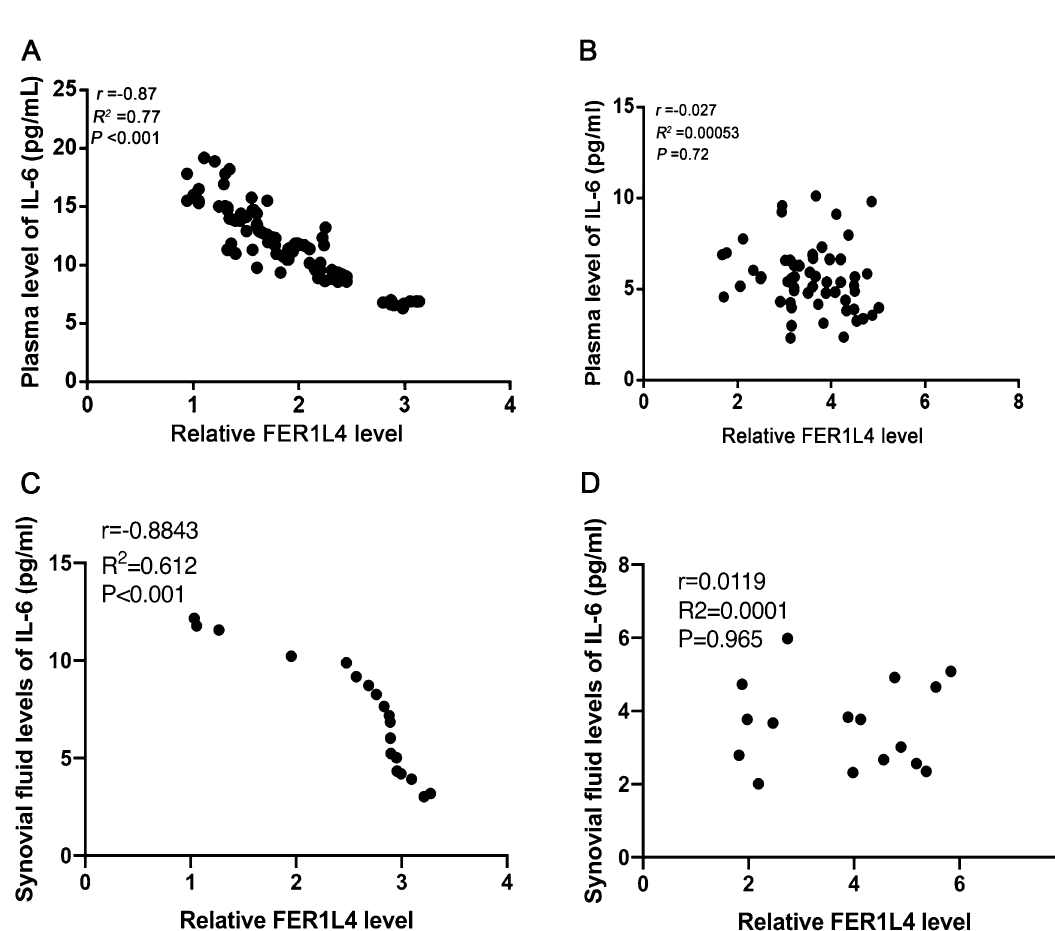
Figure 3. FER1L4 and IL ‐ 6 were inversely correlated in OA patients Pearson’s correlation coefficient analysis was performed to analyze the correlation between of FER1L4 and IL-6 in plasma of OA patients ( A ) and healthy controls ( B ), as well as in synovial fluid of OA patients ( C ) and healthy controls ( D